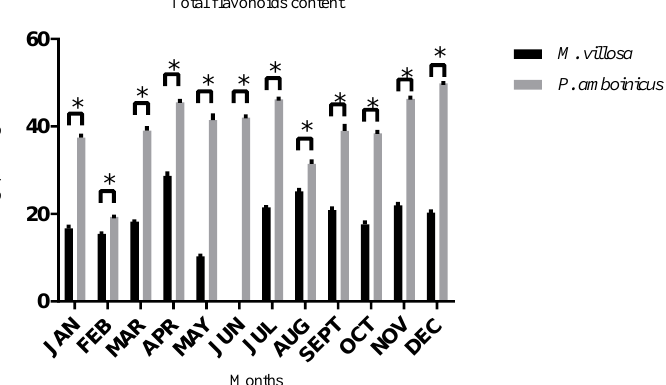
Figure 2. Flavonoids content of M. villosa and P. amboinicus throughout 12 months and their statistical differences. * statistical difference